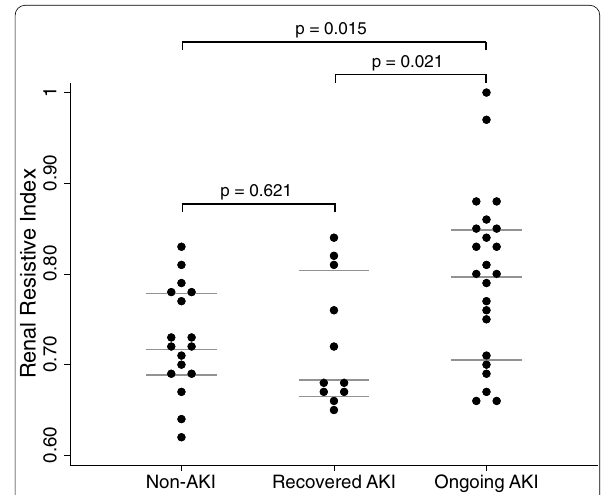
Fig. 3 Dot plot illustrating the association between renal resistive index and acute kidney injury (AKI) in patients who did not develop AKI, developed AKI but recovered, and had an ongoing AKI episode at the time of measurement. Each dot represents a patient. The horizontal lines represent the median, upper and lower